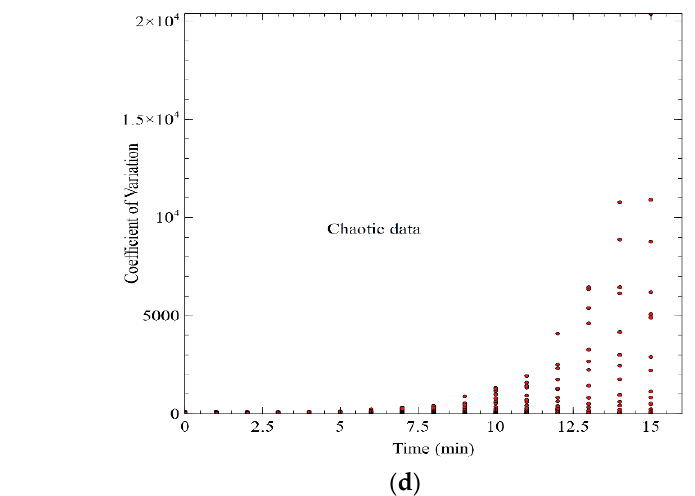
Figure A9. Result for LGP-2 for time evolutions. ( a ) Weight of each sizer fluctuation zone of the reconstructed data for ore-A; ( b ) Cv for ore-A. ( c ) Weight of each sizer fluctuation zone of the reconstructed data for ore-B; ( d ) Cv for ore-b.